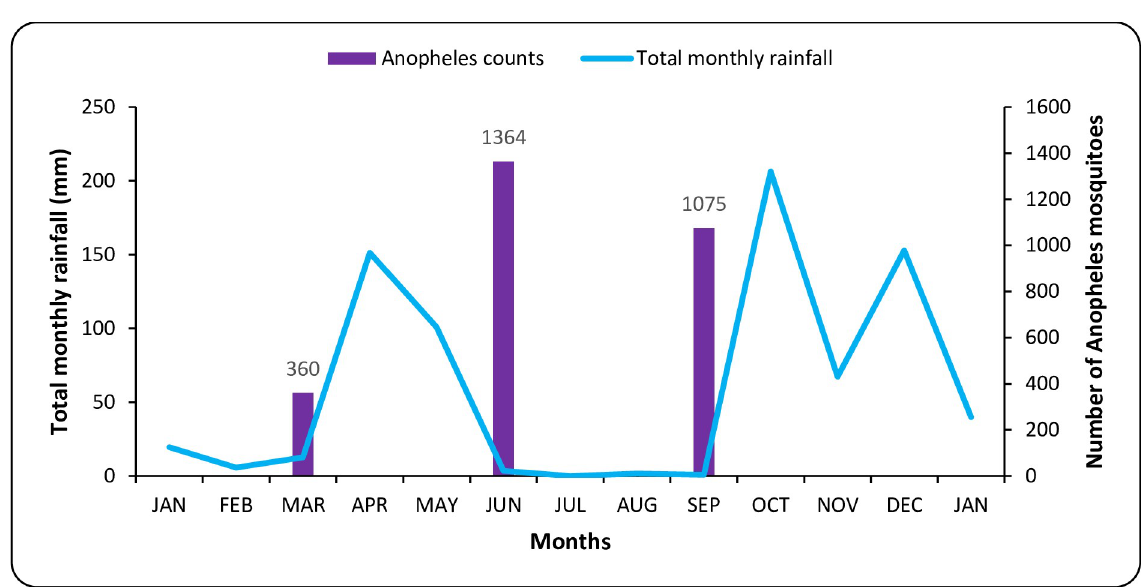
Fig 2. Anopheles mosquitoes collected in all villages (32 households) at three time points and total monthly rainfall for Lower Moshi.